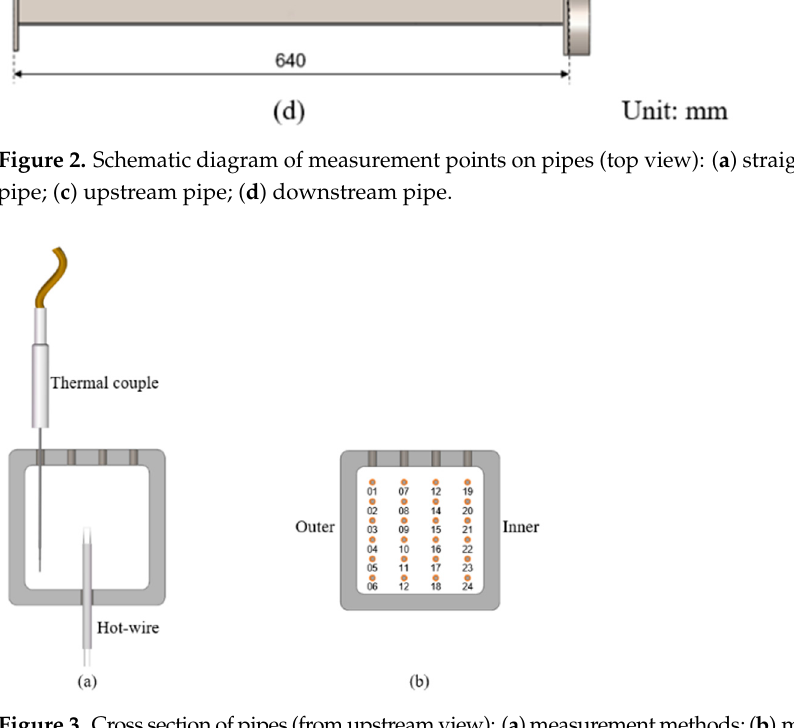
Figure 3. Cross section of pipes (from upstream view): ( a ) measurement methods; ( b ) measurement points.